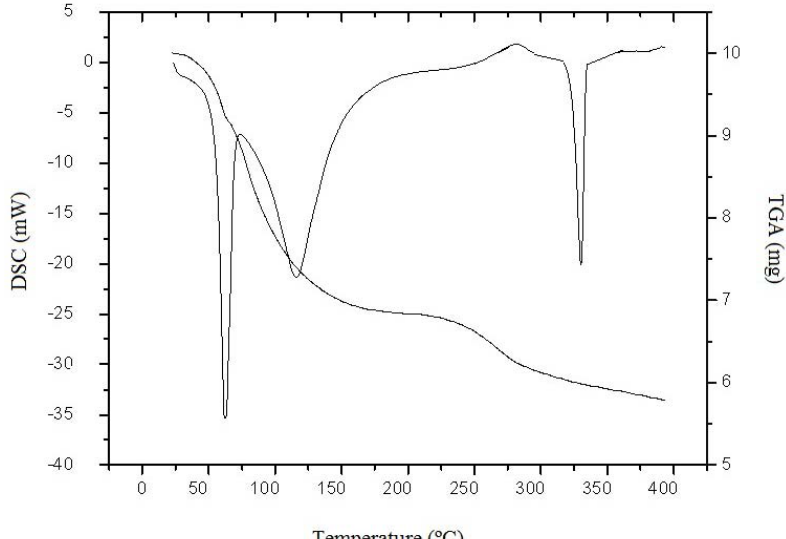
Figure 3. DSC and TGA termograms of chitosan from Mucor circinelloides UCP